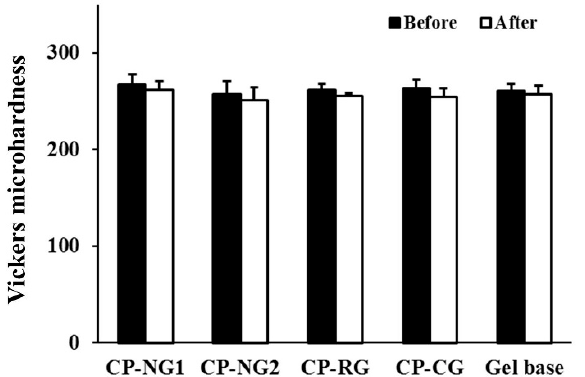
Figure 7. Values of the enamel microhardness, measured as Vickers hardness number, before and after bleaching by CP gel formulations and gel base.